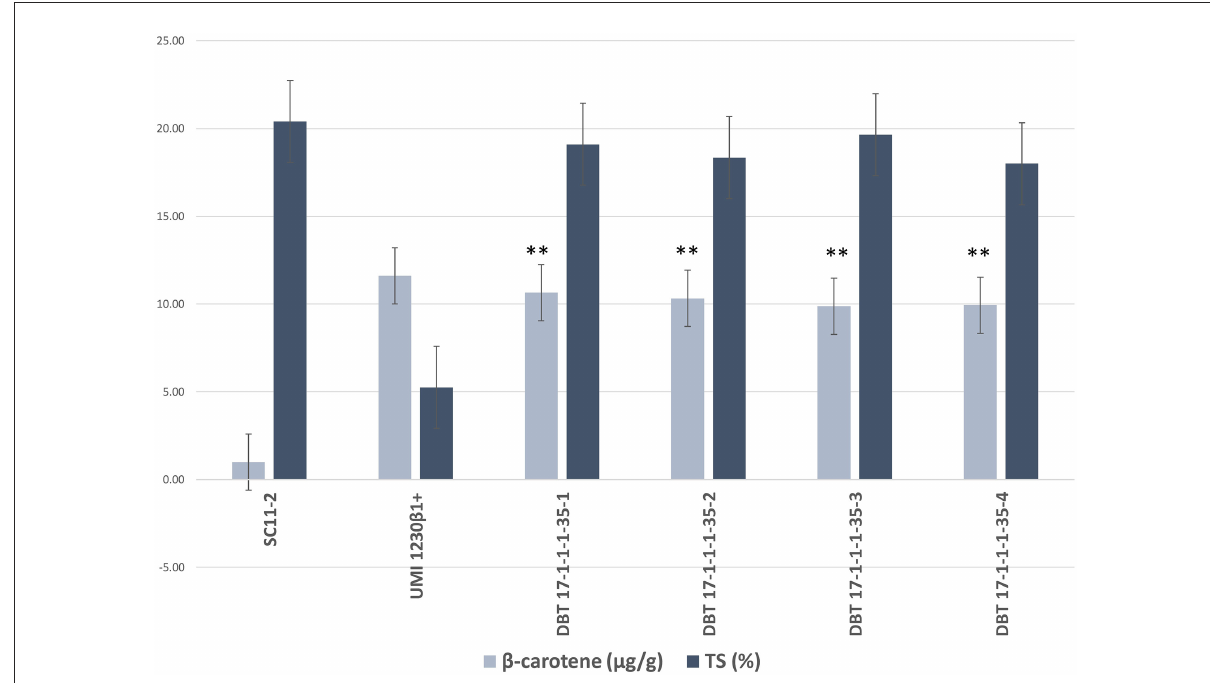
FIGURE5 Total sugar (%) and β -carotene ( µ g/g) content in parents and improved lines from BC 2 F 3 generation of SC11-2 × UMI 1230 β 1 + . Error bars indicate means ± SE. Asterisks (**) indicate significant different from the recurrent parent β -carotene ( µ g/g) content using t -test ( p <